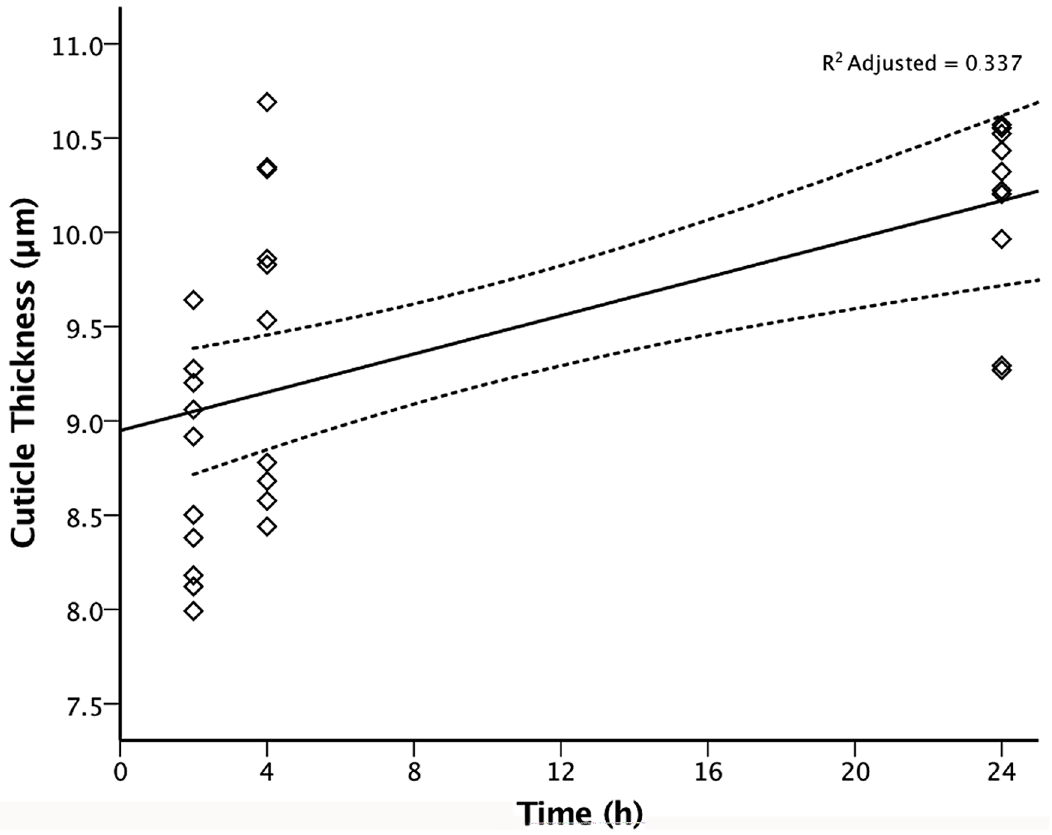
Fig 4. Positive correlation of time-to-knockdown to mean cuticle thickness of Parramatta strain Cimex lectularius (n = 10 per response group) upon continuous forced-exposure to wet residues of 20 mL/L Demand Insecticide 1 (25 g/L lambda-cyhalothrin).